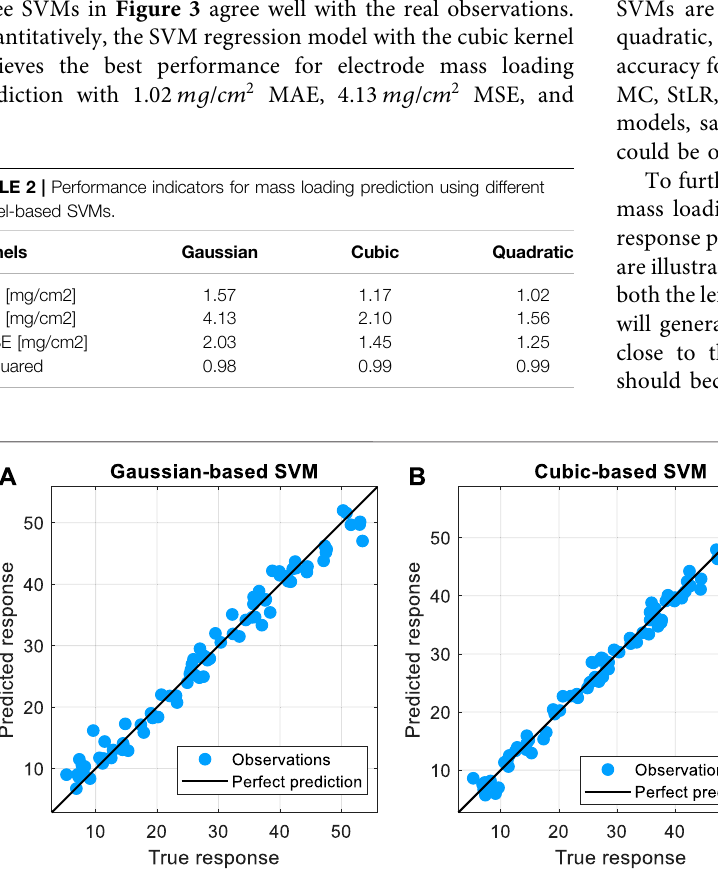
Frontiers in Energy Research |